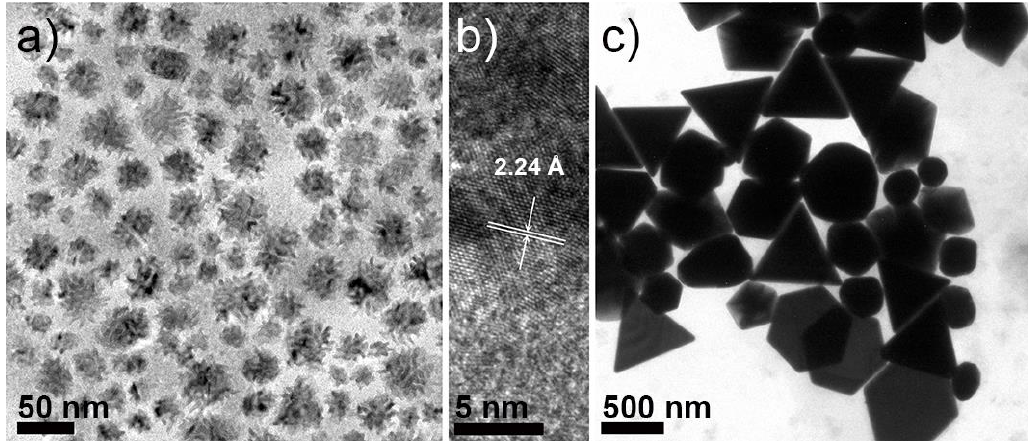
Figure 2. TEM and HR TEM images of ( a ) Pd DNPs, ( b ) Pd DNPs and TEM image of ( c ) Au NPs.